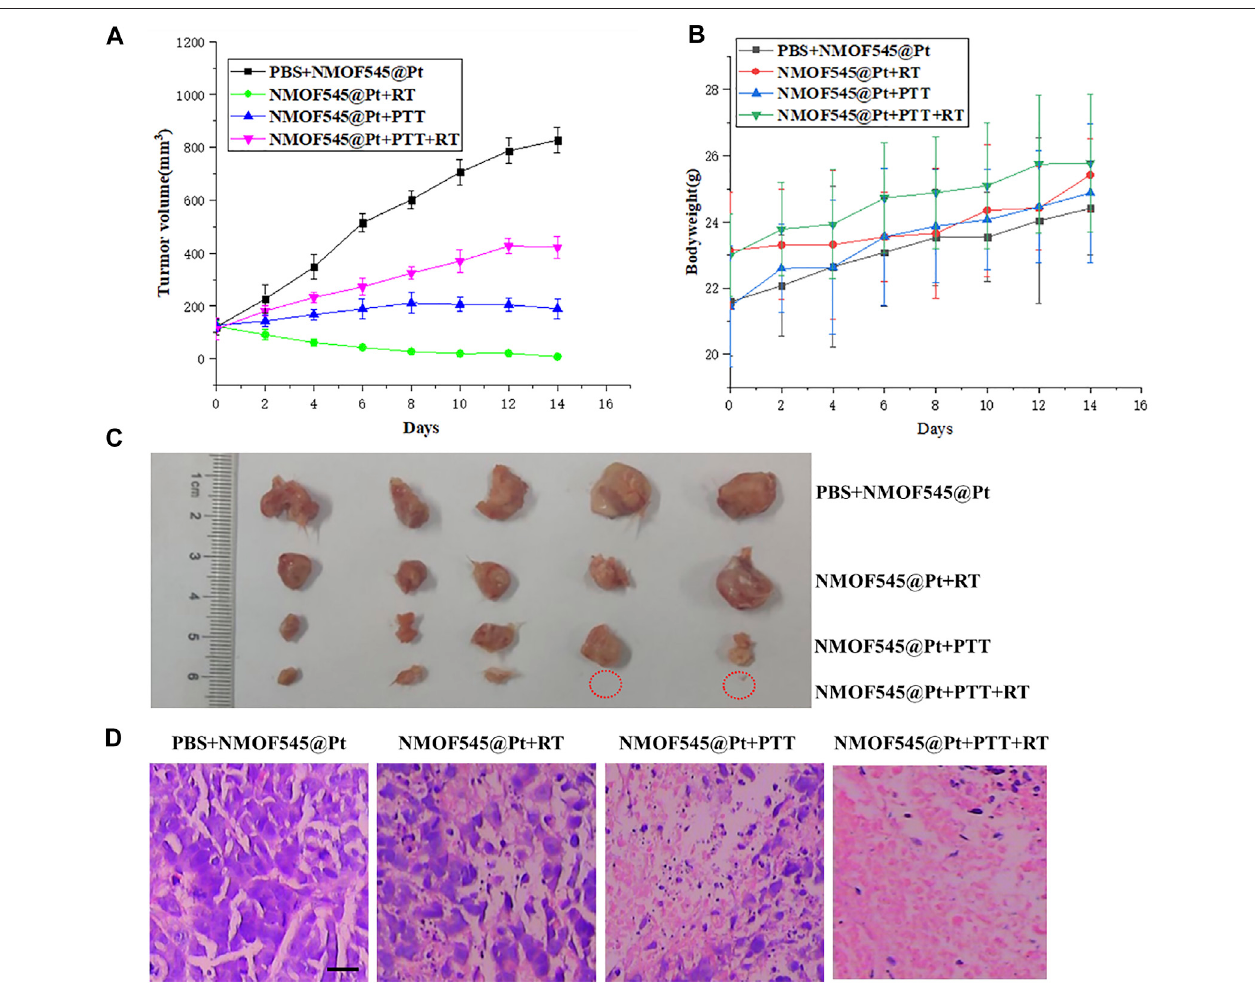
FIGURE5| Invivo tumortherapyef fi ciencyofNMOF545@Ptnanoparticles. (A) Bodyweightandtumorsvolume. (B) Changingcurvesof4T1tumor-bearingmiceat different time points after various treatments. (C) Photographs of all excised tumors in mice were sacri fi ced at the end of observation and the red circles denoted the disappeared tumors. (D) H&E staining of tumors shows the organizational structure in different groups (scale bar, 100 μ m).